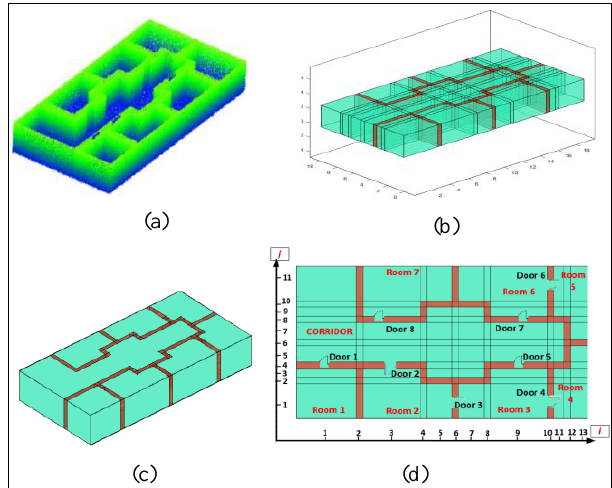
Figure 2. The geometric and semantic reconstruction of the synthetic point cloud of the first floor. (a) the input point cloud; (b) the result of cuboid placement, classification, and merging; (c) the final 3D indoor model; (d) the top-view of the 3D model with space labels and grid coordinates ( i , j ). The doors are added manually.